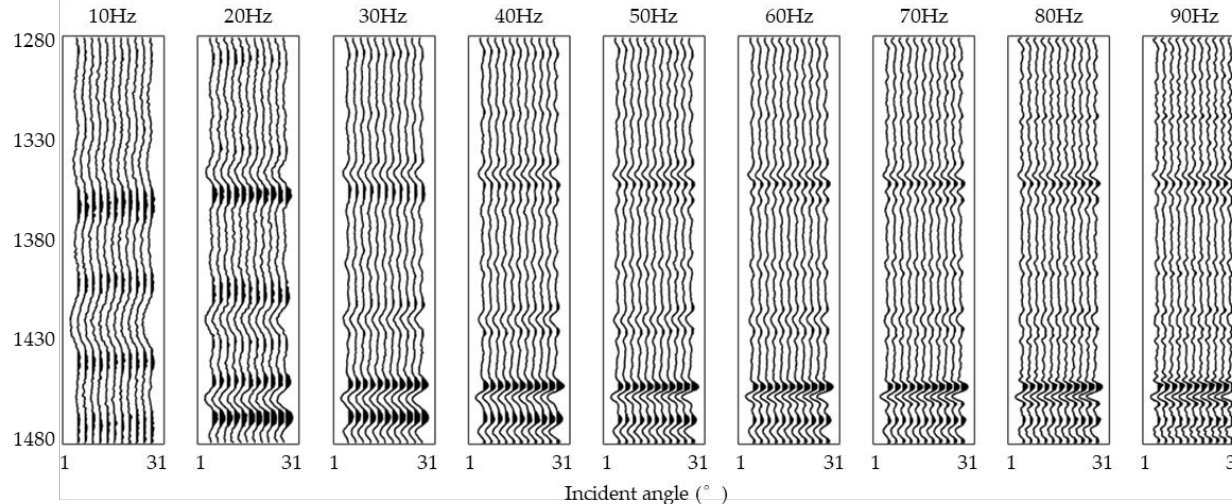
Figure 9. The synthetic seismic data which added Gaussian random noise with S/N of 5. These results will be used as the observed seismic data for inversion. The lower frequency data affected more by noises.